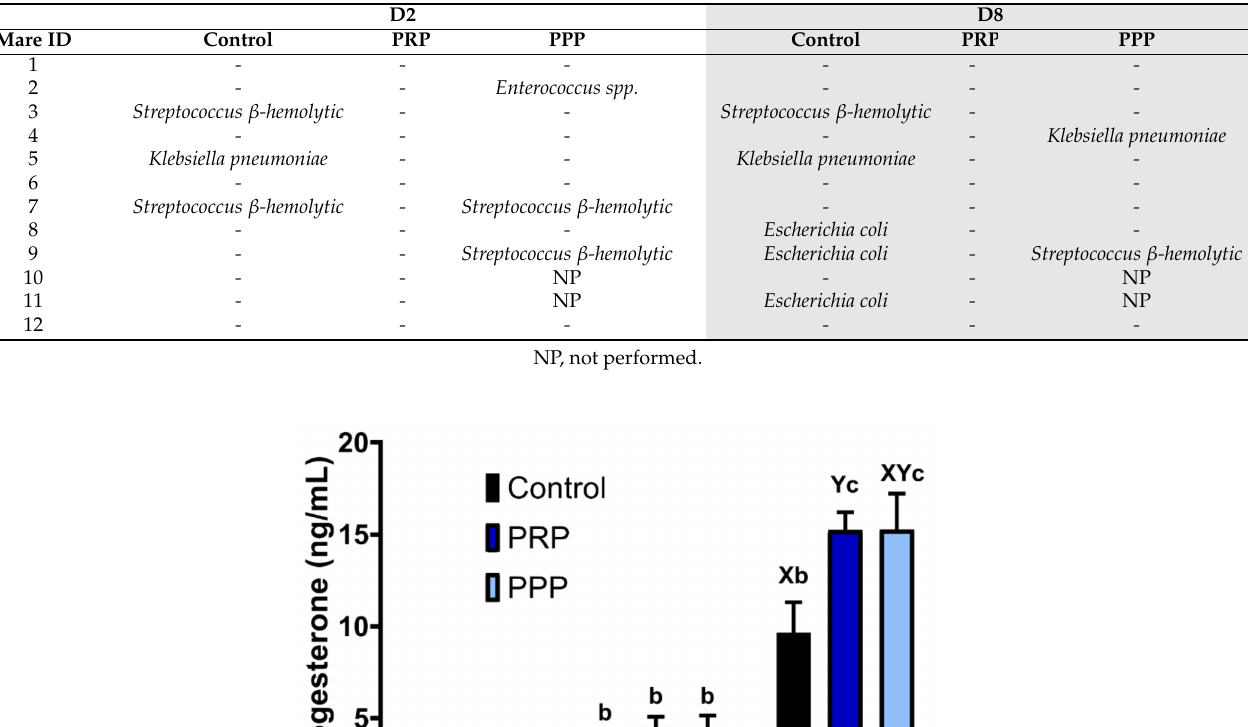
Table 2. Aerobic culture results of aerobic obtained Day 2 (D2) and Day 8 (D8) post-ovulation in mares susceptible to persistent breeding-induced endometritis. Estrous cycles ( n = 34) from twelve mares were assigned in a crossover design to receive intrauterine uterine infusions with Lactated Ringer’s Solution (Control, n = 12), platelet-rich (PRP, n = 12) or -poor plasma (PPP, n = 10).